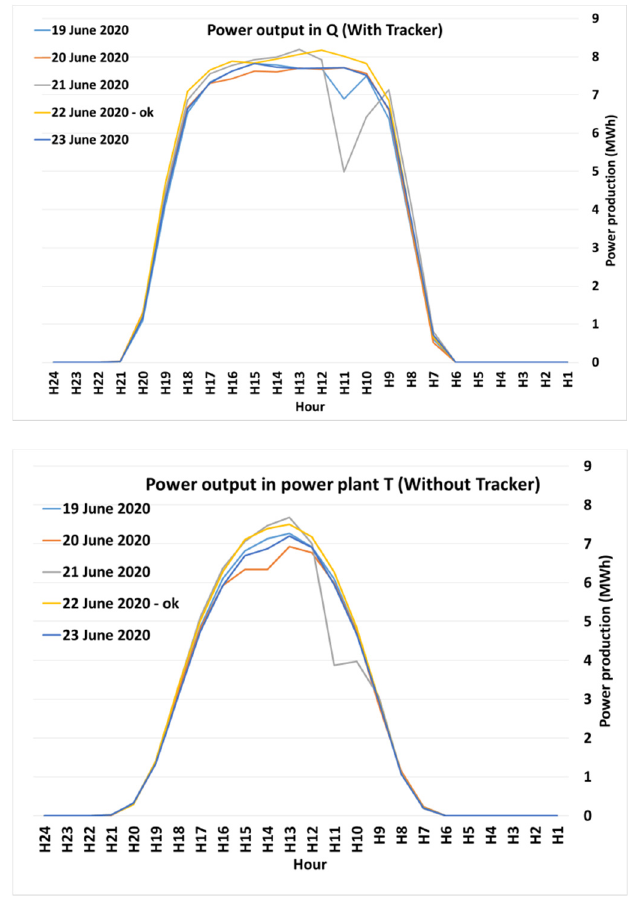
Figure 2. Examining the production curve of two power plants Q (with a tracker) and T (without a tracker) with the aim of finding a suitable day for comparison in the summer. After choosing the right day for comparison, the production curves of these two power plants were compared. As Figure 3 suggests, the production in the Q power plant with an east-west tracker started earlier with more intensity. At sunset, the production ended later and continued with greater intensity until the full evening. Comparing the total daily energy production (the area under the curve) of the two power plants on 22 June 2020 showed that the production of the power plant with the tracker was nearly 44% higher, although the power plant without the tracker is almost a year older. Considering that the geographical location, age and type of equipment used in the two power plants are different, the above comparison cannot be completely accurate. At noon, when the sun is at the highest angle, the T power plant, if installed with a suitable angle towards the south, should have higher production than the Q power plant. However, due to the structure of this power plant, it does not have an angle to the south. From a scientific point of view, with the same geographical location and equipment, the maximum point of production in power plants without trackers should be slightly higher than those with east-west trackers, which do not have a suitable angle to the south. Accordingly, in the diagram below, nearly 10% was added to the production of the power plant without a tracker to compensate for the issues such as the older life of the power plant, the equipment used in it, and the higher latitude.